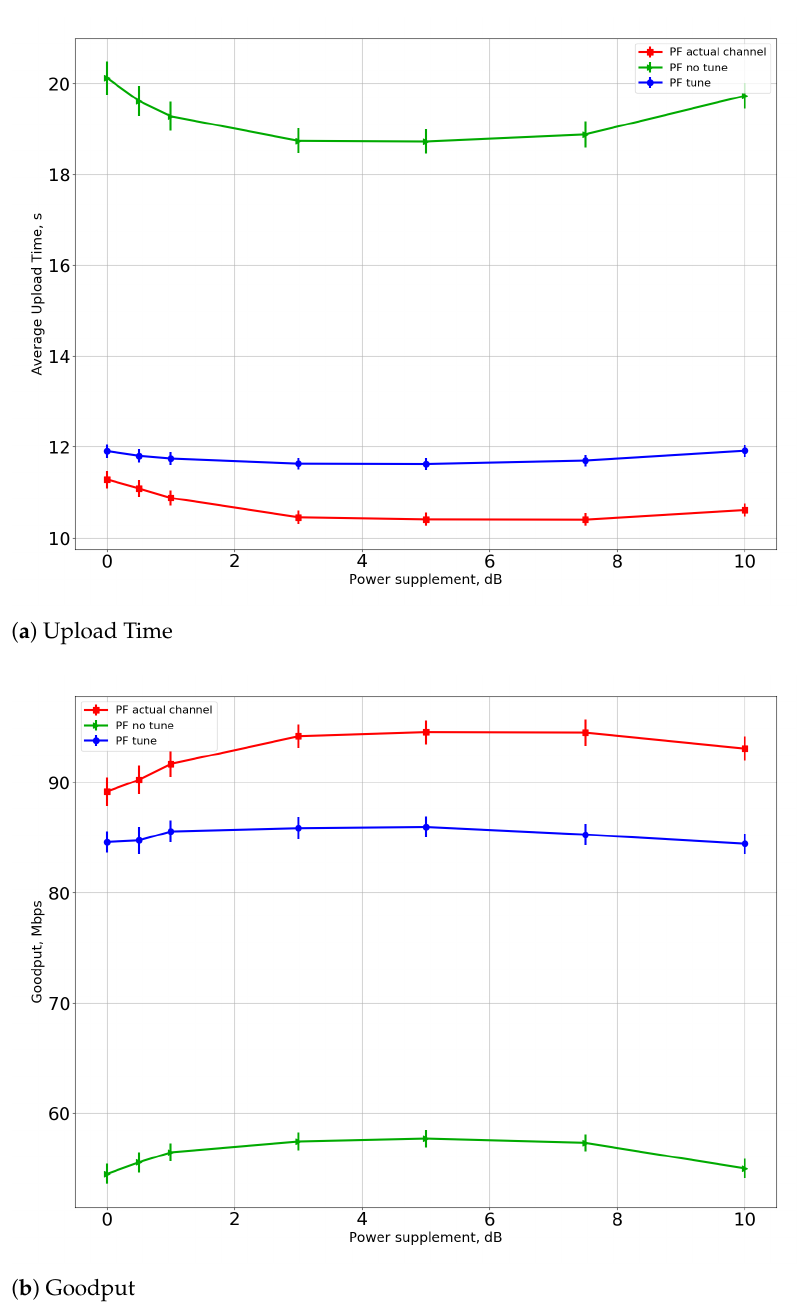
Figure 9. ( a ) Upload time and ( b ) goodput for power supplement for R =